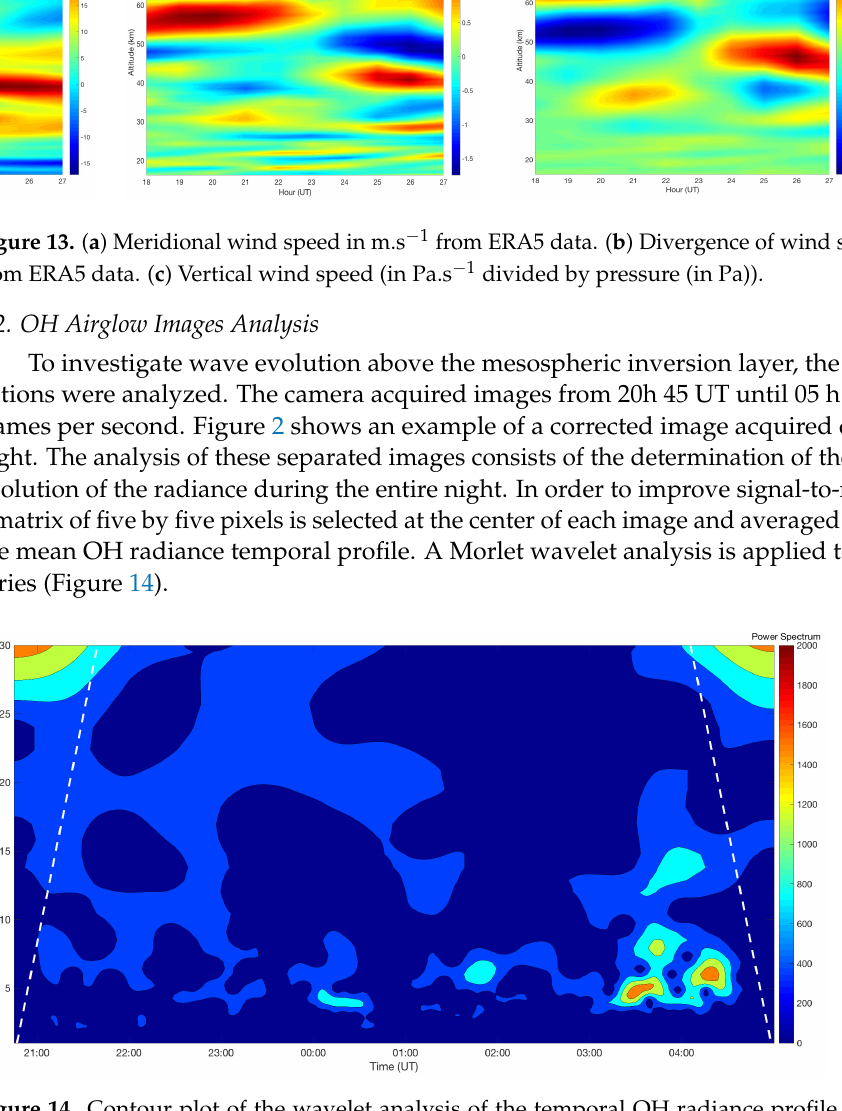
Figure 14. Contour plot of the wavelet analysis of the temporal OH radiance profile. The white dashed lines represent the cone of influence that delimits the real periods of the